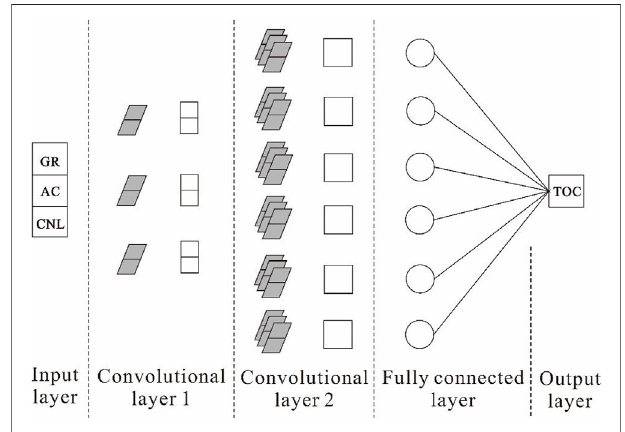
FIGURE 6 | Structure diagram of convolutional neural network.